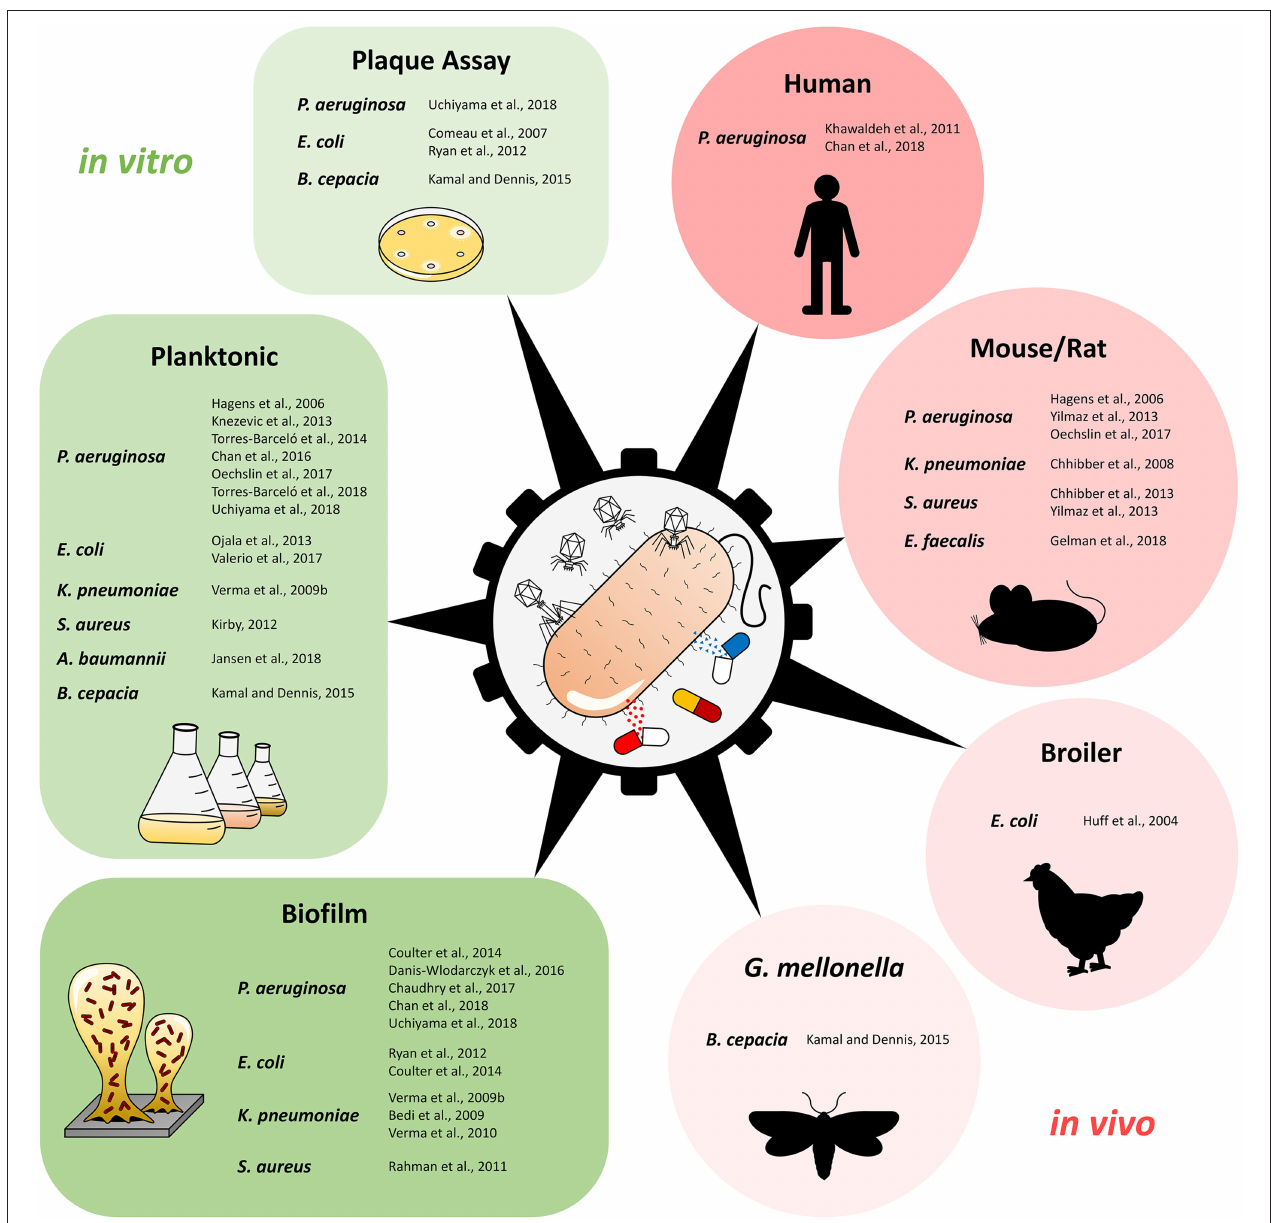
FIGURE 1 | Overview of studies using phage-antibiotic combinations against pathogenic bacteria, separated by type of study and experimental design. Plaque Assay refers to studies that investigated phage-antibiotic synergy (PAS) based on plaque size on solid media.